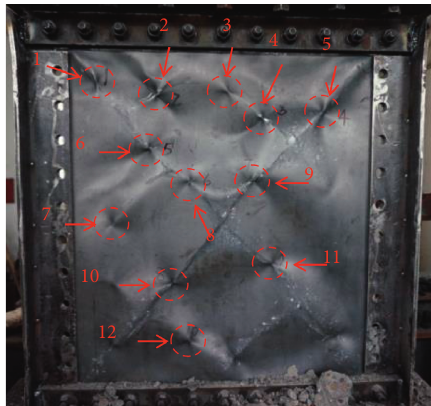
Figure 14: Destruction of infilled steel plate.